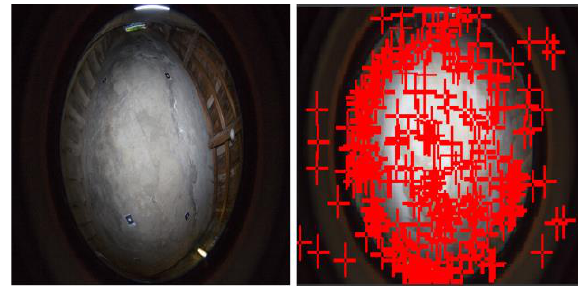
Figure 7: Capture a castle aisle with the fisheye lens and its passing points in an uncalibrated image.